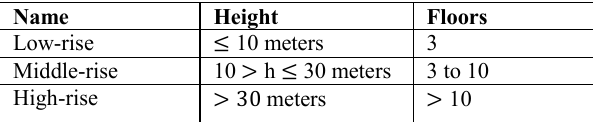
Table 2: Building height classification in Kenya